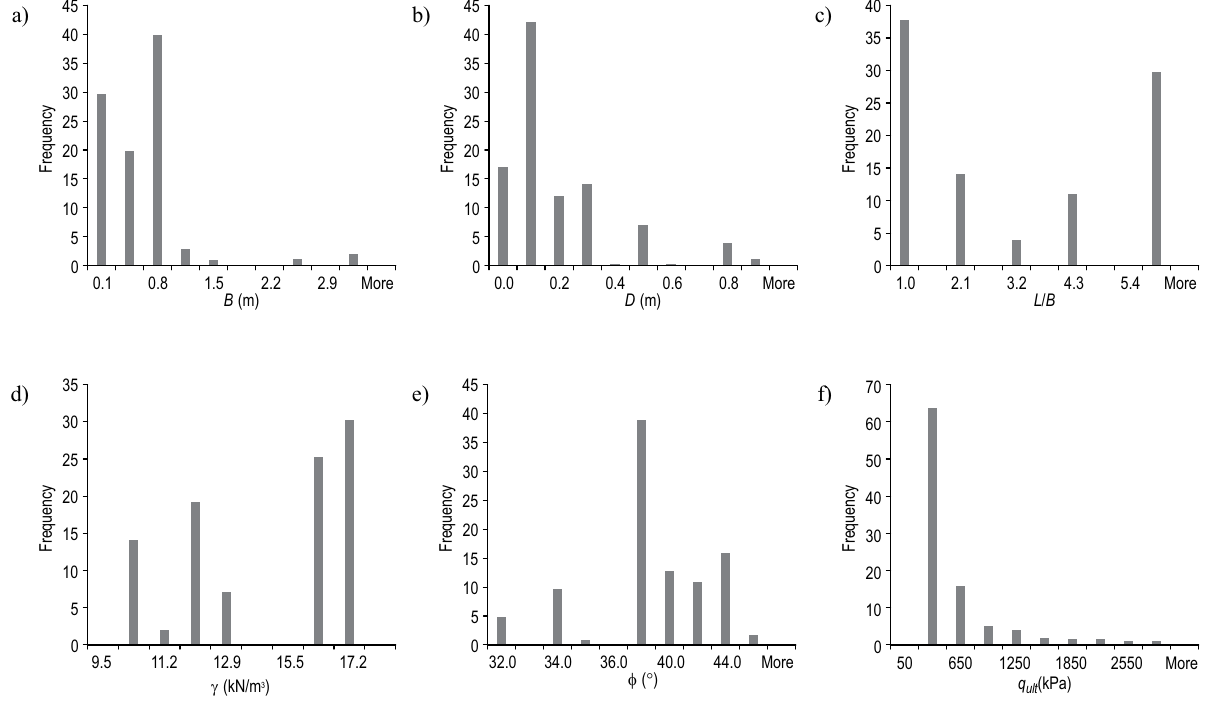
Fig. 6. Histograms of the variables used for the model development available data sets are randomly divided into three sets: (1) learning, (2) validation, and (3) testing subsets. The learning data are used for the genetic evolution. The vali-